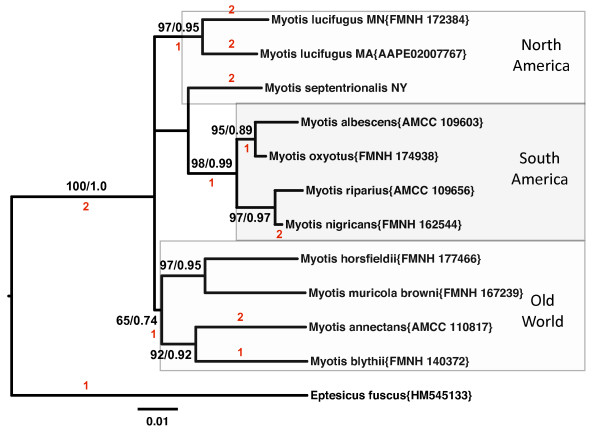
Midpoint rooted maximum likelihood phylogram of filovirus-like nucleoprotein (NP) nucleotide sequences from vespertilionid bats. Three major geographic clades of the genus Myotis are shown by shaded boxes -- the big brown bat (Eptesicus fuscus) sequence has been added for comparison and to show the rooting that divides Old and New World Myotis. Support values (nonparametric bootstrap support/approximate likelihood ratio tests) are given above the branches. GenBank accession numbers or museum voucher numbers are provided in parentheses. See Additional file 8, Table S3 for details of specimen records and acronyms. Red numbers indicate the sum and presumed phylogenetic position of independent observed disruptions to the open reading frame. The scale bar is based on substitutions per site.